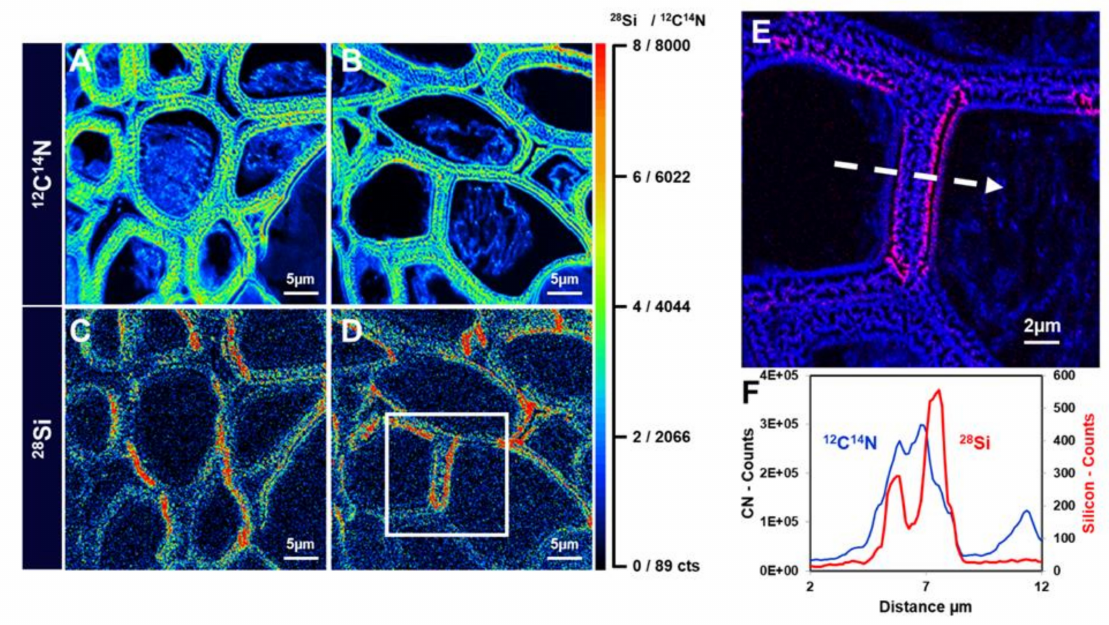
Figure 9. NanoSIMS images of hemp hypocotyl. ( A ) and ( B ) Distribution of 12 C 14 N − in the bast fibres of textile hemp grown for 15 days on 1mM sodium metasilicate. ( C ) and ( D ) 28 Si − in the bast fibres of textile hemp grown for 15 days on 1mM sodium metasilicate. ( E ) Zoomed image of the white box in ( D ). ( F ) Linescans of the 12 C 14 N and 28 Si in ( E ) (relative to the region marked with the white dotted arrow). The colour scale goes from black to red with increasing intensity. The scale bars are 5 µ m in panels ( A – D ) and 2 µ m in panel ( E ). Images were taken using a CAMECA NanoSIMS 50 instrument (Gennevilliers,